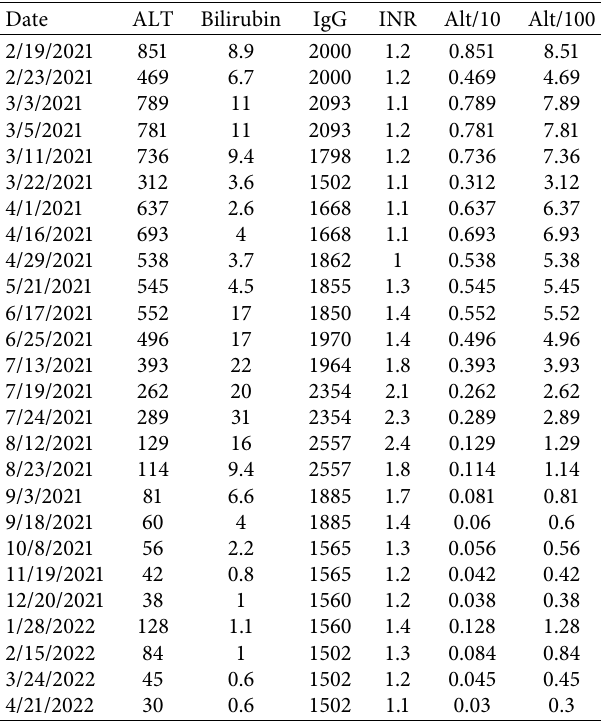
Table 1 Evolution of liver tests after COVID-19